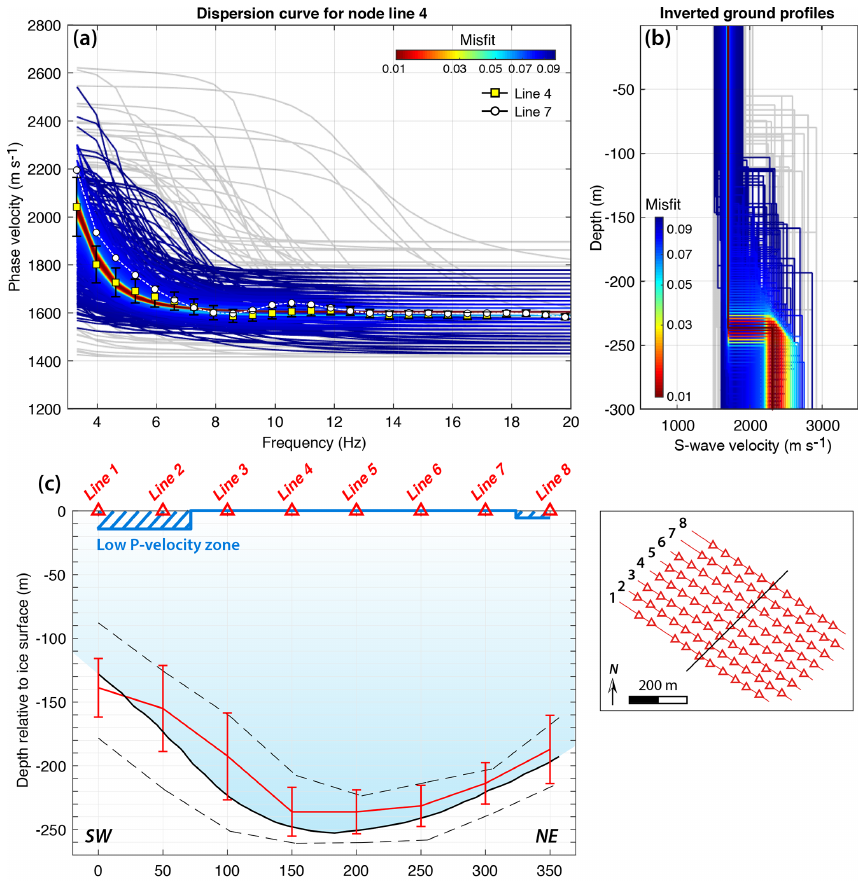
Figure 5. Inversion of glacier thickness using velocity dispersion curves of Rayleigh waves and the Geopsy neighborhood algorithm. Disper- sion curve measurements are obtained from f-k analysis of noise cross-correlations on eight receiver lines whose geometry is described in the bottom-right panel. (a, b) Color-coded population of (a) dispersion curve fits and (b) S-wave velocity profiles for the node along-flow line labeled 4 in (c) . Warmer colors correspond to smaller misfit, and gray lines correspond to models with misfit values higher than 0.1. In (a) the dispersion curve and uncertainties obtained from seismic measurements are overlaid in yellow squares. For comparison, the dispersion curve computed for the node line 7 and associated with a thinner ice layer is plotted in white dots. (c) Across-flow profile of (red line) ice thickness estimates from Rayleigh wave velocities obtained at eight along-flow node lines and (black line) average basal topography from a DEM. Dashed blue zones indicate the presence of a low P-velocity top layer from seismic inversions. Uncertainties in ice thickness estimates (red error bars) correspond to seismic inversion results which yield to a misfit lower than 1 standard deviation of misfit values from the 2500 best-fitting models. Black dashed lines indicate deviations from the glacier baseline around each node line due to longitudinal topography